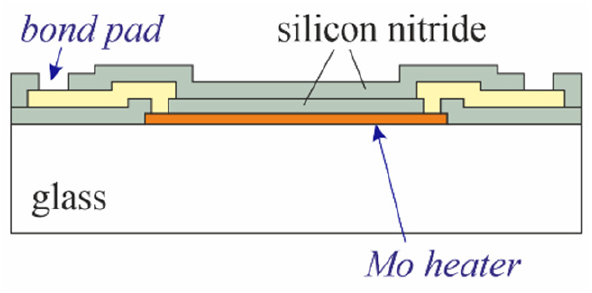
Figure 4. Cross-section through a finished sensor on glass.